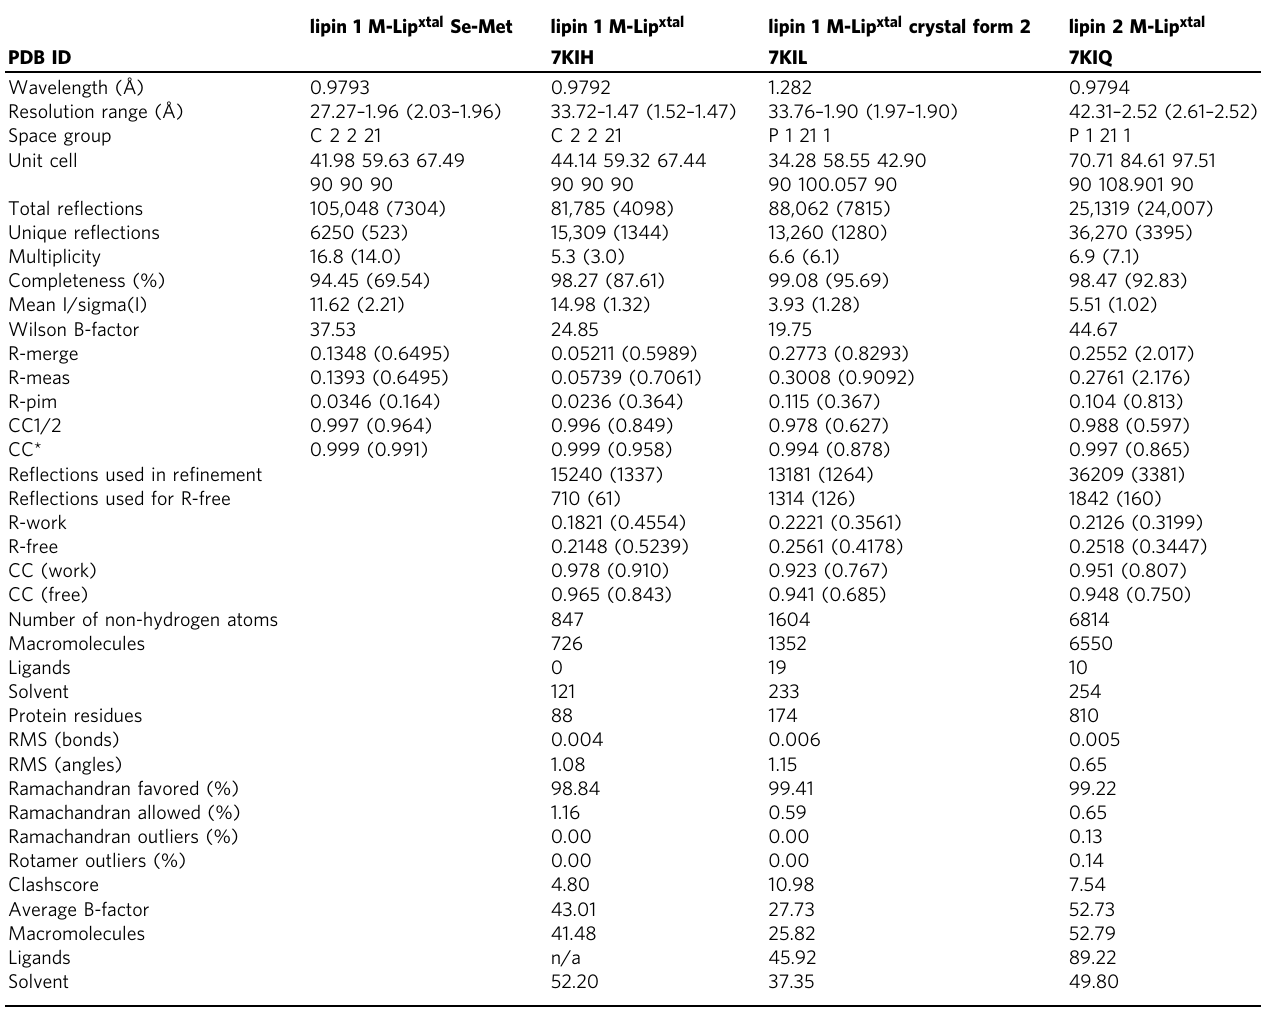
Table 1 Data collection and re fi nement